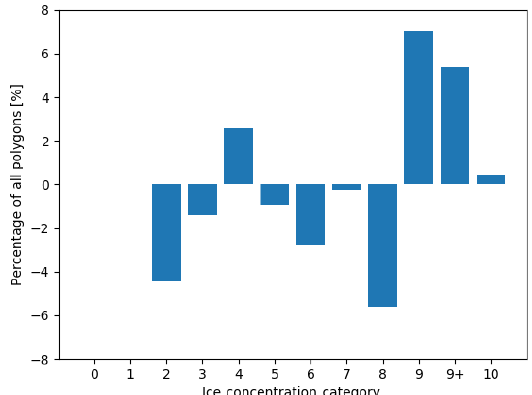
Figure 12. The difference in the distribution of polygons across ice concentration categories for validated polygons (visually esti- mated ice concentration minus MAGIC). The vertical axis shows the change in the proportion of polygons. The horizontal axis shows the ice concentration